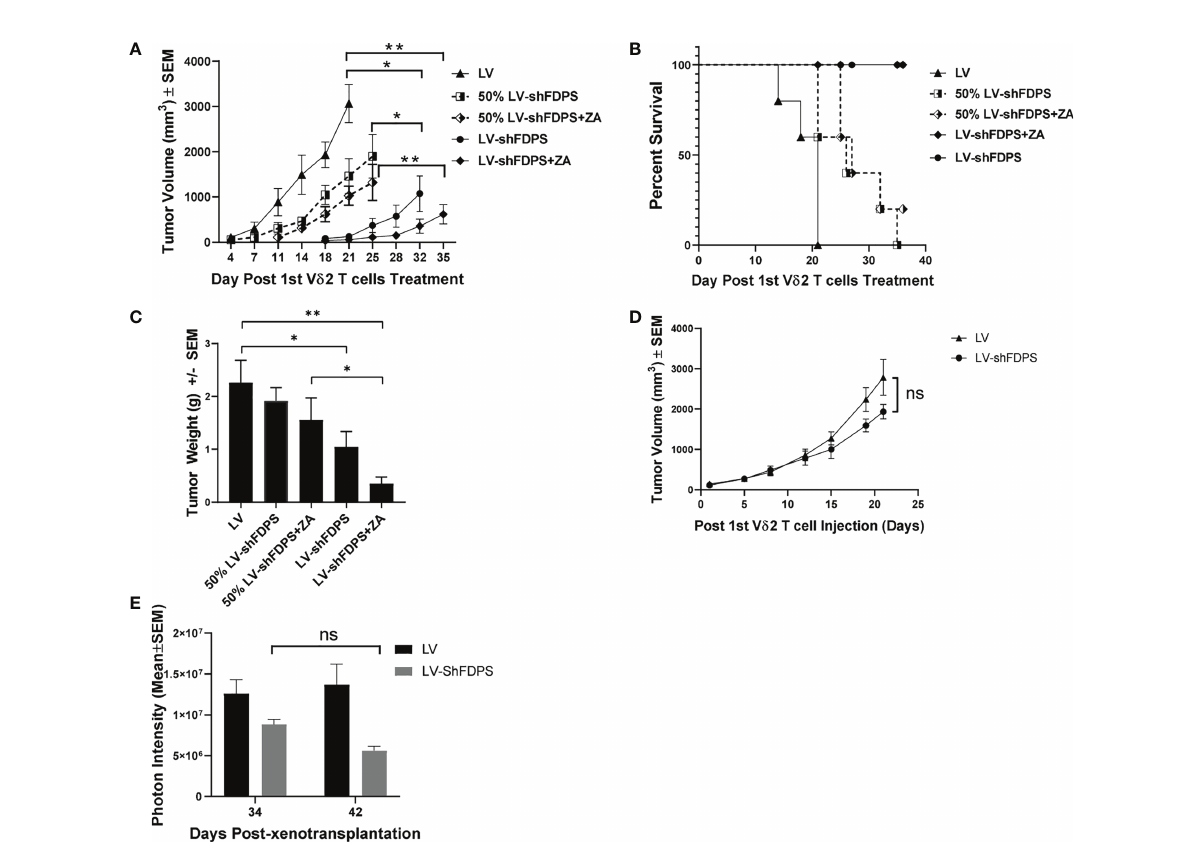
FIGURE 5 V d 2 T cells suppress the growth of Huh-7 hepatocellular tumors transduced with a lentivirus expressing a shRNA targeting FDPS. (A) Tumor volume in mice with LV, 100% LV-shFDPS or 50% LV-shFDPS transduced Huh-7 cells in the presence or absence of ZA. The tumor volume of 100% LV-shFDPS and 50% LV-shFDPS tumors was decreased as compared with LV tumors in the presence or absence of ZA. There was a signi fi cant decrease in tumor volume in mice with 100% LV-shFDPS and treated with ZA or without ZA as compared with LV tumors (** p =0.001, * p =0.014, N=5). The tumor volumes in mice implanted with 100% LV-shFDPS transduced cells were signi fi cantly lower than in mice who received 50% transduced cells (* p =0.024, N=5). (B) A Kaplan-Meier survival curve of mice which were transplanted with LV, LV-shFDPS, or 50% LV-shFDPS transduced Huh-7 cells in the presence or absence of ZA. Each group of mice (N=5) was euthanized when tumors reached 2000 mm 3 . The survival of mice with LV transduced tumors was reduced versus mice with LV-shFDPS and 50% LV-shFDPS transduced